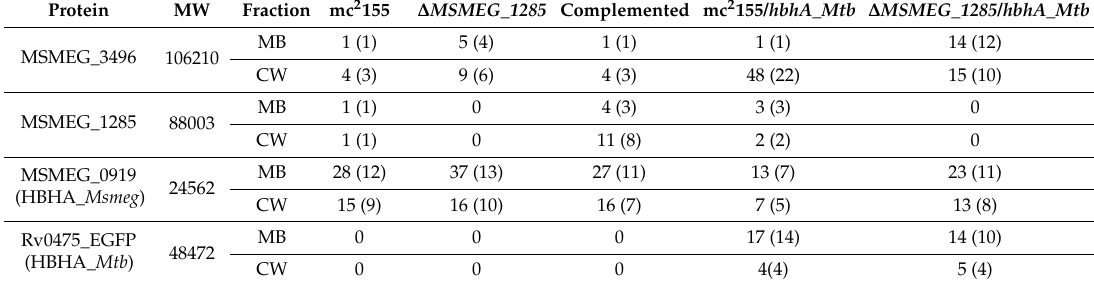
Table 1. Total number of spectra (and unique peptides) for each protein in Membrane (MB) and Cell Wall (CW)